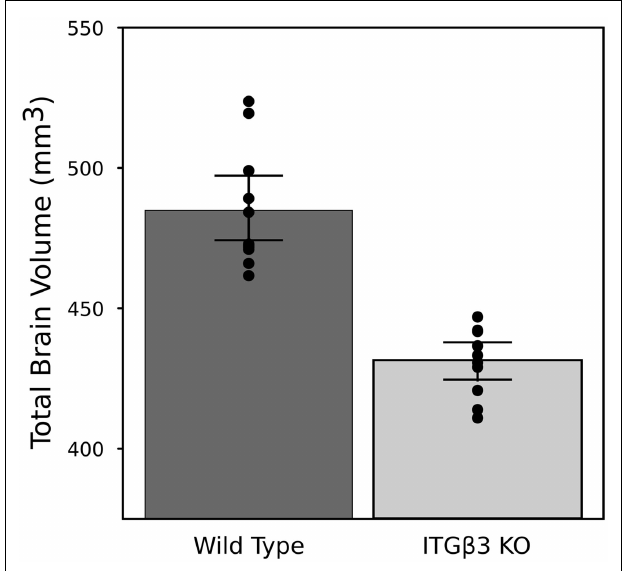
FIGURE 1 | Highlights the difference in overall brain volume between the ITG β 3 KO mouse model and the correspondingWT. The points represent the individual brain volumes, and the error bars represent the 95% confidence interval.